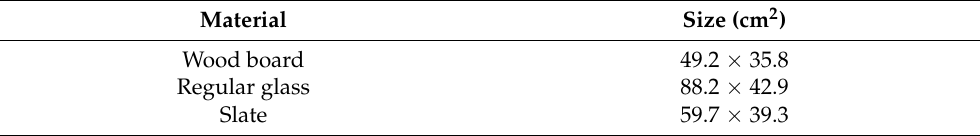
Table 3. The details about the occluders.